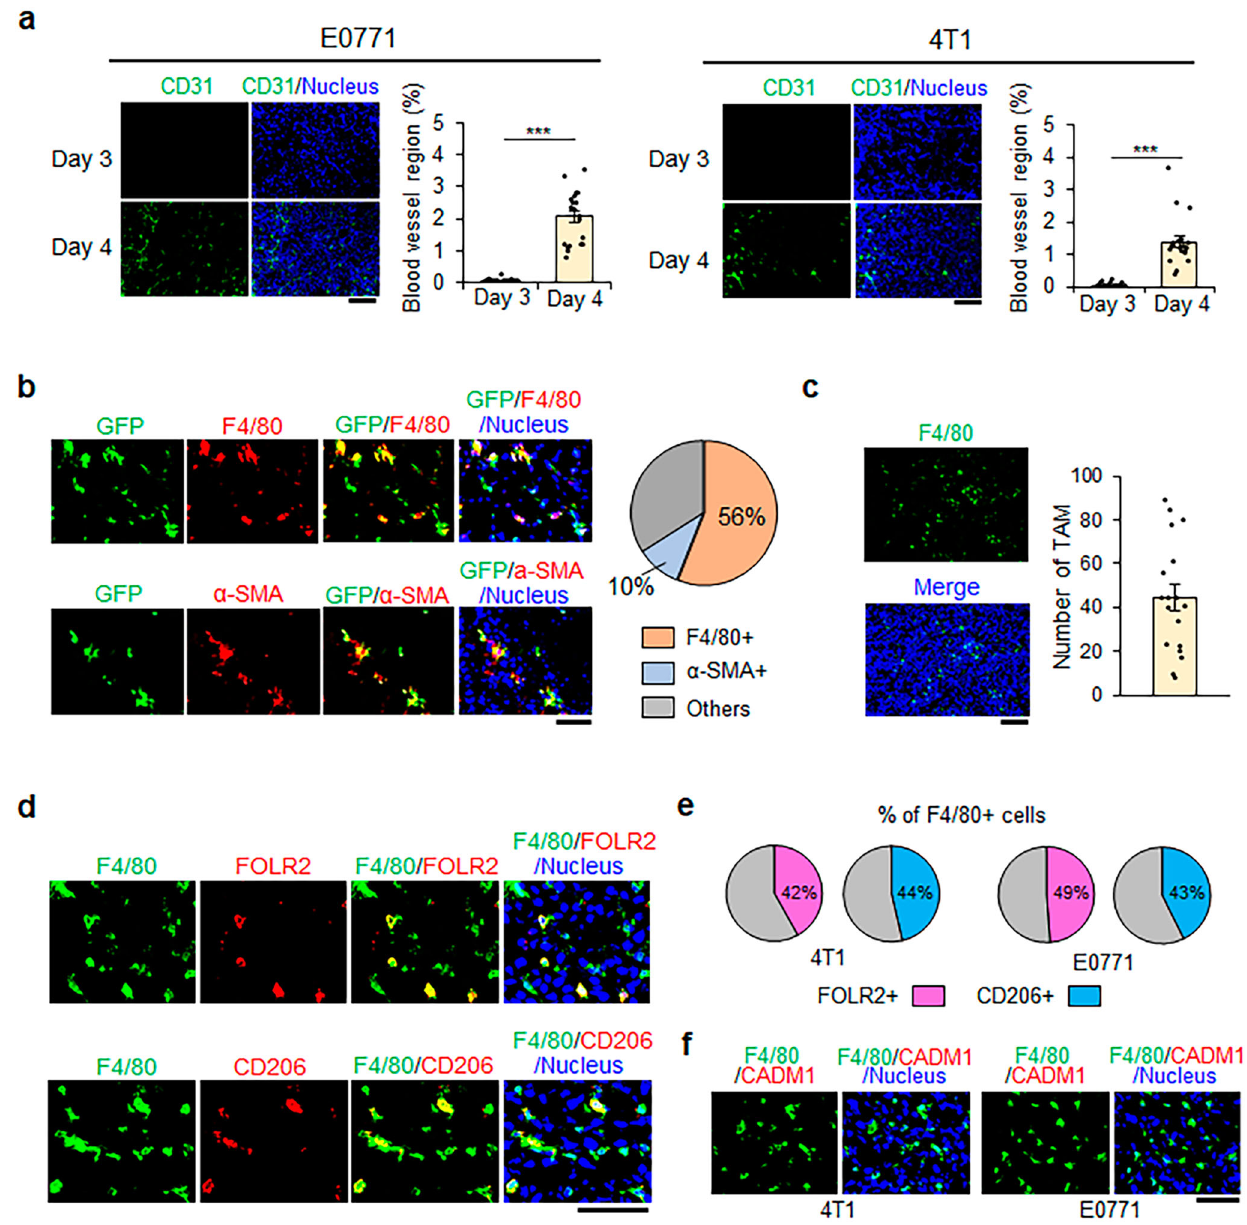
Fig. 1 In fi ltration of mammary gland tissue-resident macrophages (MGTRMs) in pre-angiogenic triple-negative breast cancer (TNBC). a Representative fl uorescence images (left-hand panel) and average % of the CD31 + area (right-hand panel) in tumors (1 – 2 mm in diameter) 3 and 4 days after the transplantation of indicated TNBC cells. n = 20. *** p < 0.001 ( t -test). Scale bar = 100 µ m. b Sections of E0771 tumors (~1 mm in diameter) in green fl uorescent protein (GFP)-transgenic mice 3 days after transplantation. Representative fl uorescence images of GFP + , F4/80 + , and α -smooth muscle actin (SMA) + cells (left) and average % of F4/80 + and α -SMA + cells among GFP + cells (right). n = 20. Scale bar = 50 µ m. c Representative image (left) and average number of F4/80 + cells in a fi eld (right) of 4T1 tumors (~1 mm in diameter) 3 days after transplantation. n = 18. Scale bar = 100 µ m. d Sections of 4T1 tumors (~1 mm in diameter) in BALB/c mice 3 days after transplantation. Representative fl uorescence images of F4/80 + , FOLR2 + , and CD206 + cells. Scale bar = 50 µ m. e Average % of FOLR2 + and CD206 + cells among F4/80 + MGTRMs. n = 15. f Sections of TNBC (~1 mm in diameter) 3 days after transplantation. Representative fl uorescence images of F4/80 + and CADM1 + cells. Scale bar = 50 µ m. a , c Error bars indicate standard error of the mean